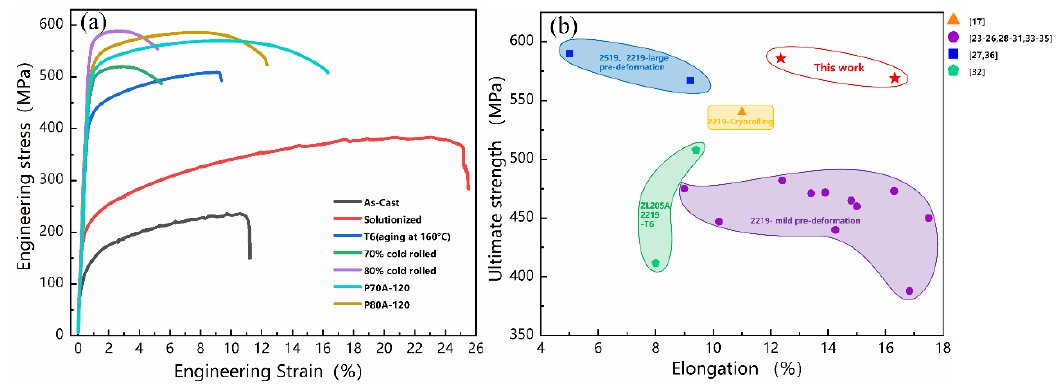
Figure 2. ( a ) Tensile engineering stress–strain curves of samples under different processing states; ( b ) the map of ultimate tensile strength–ductility combinations of existing Al-Cu-Mn alloy research [17,23–27,29–37], including our work.